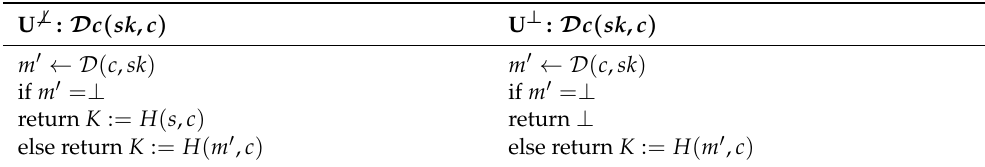
Table 3. Decapsulation algorithm for U (cid:54)⊥ and U ⊥